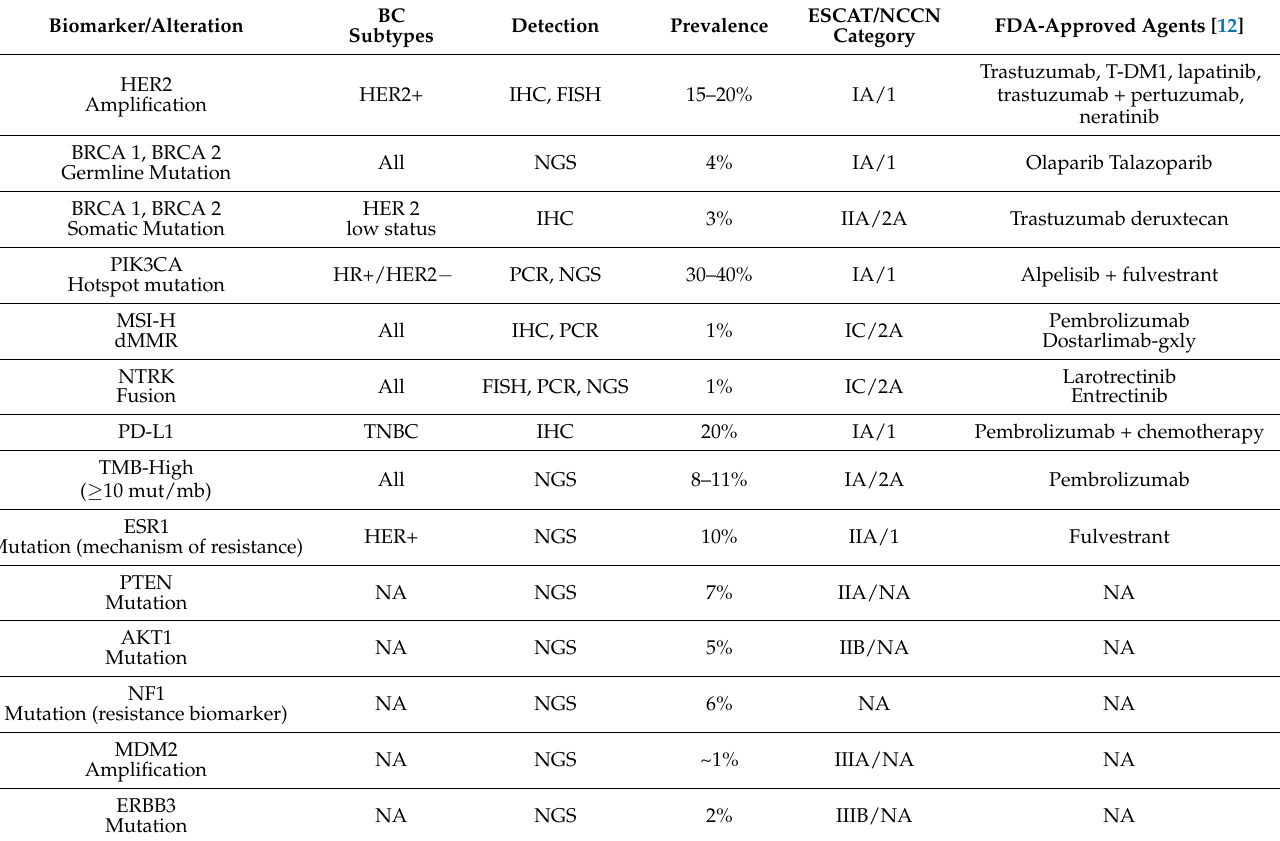
Table 2. Summary of genomic alterations in metastatic breast